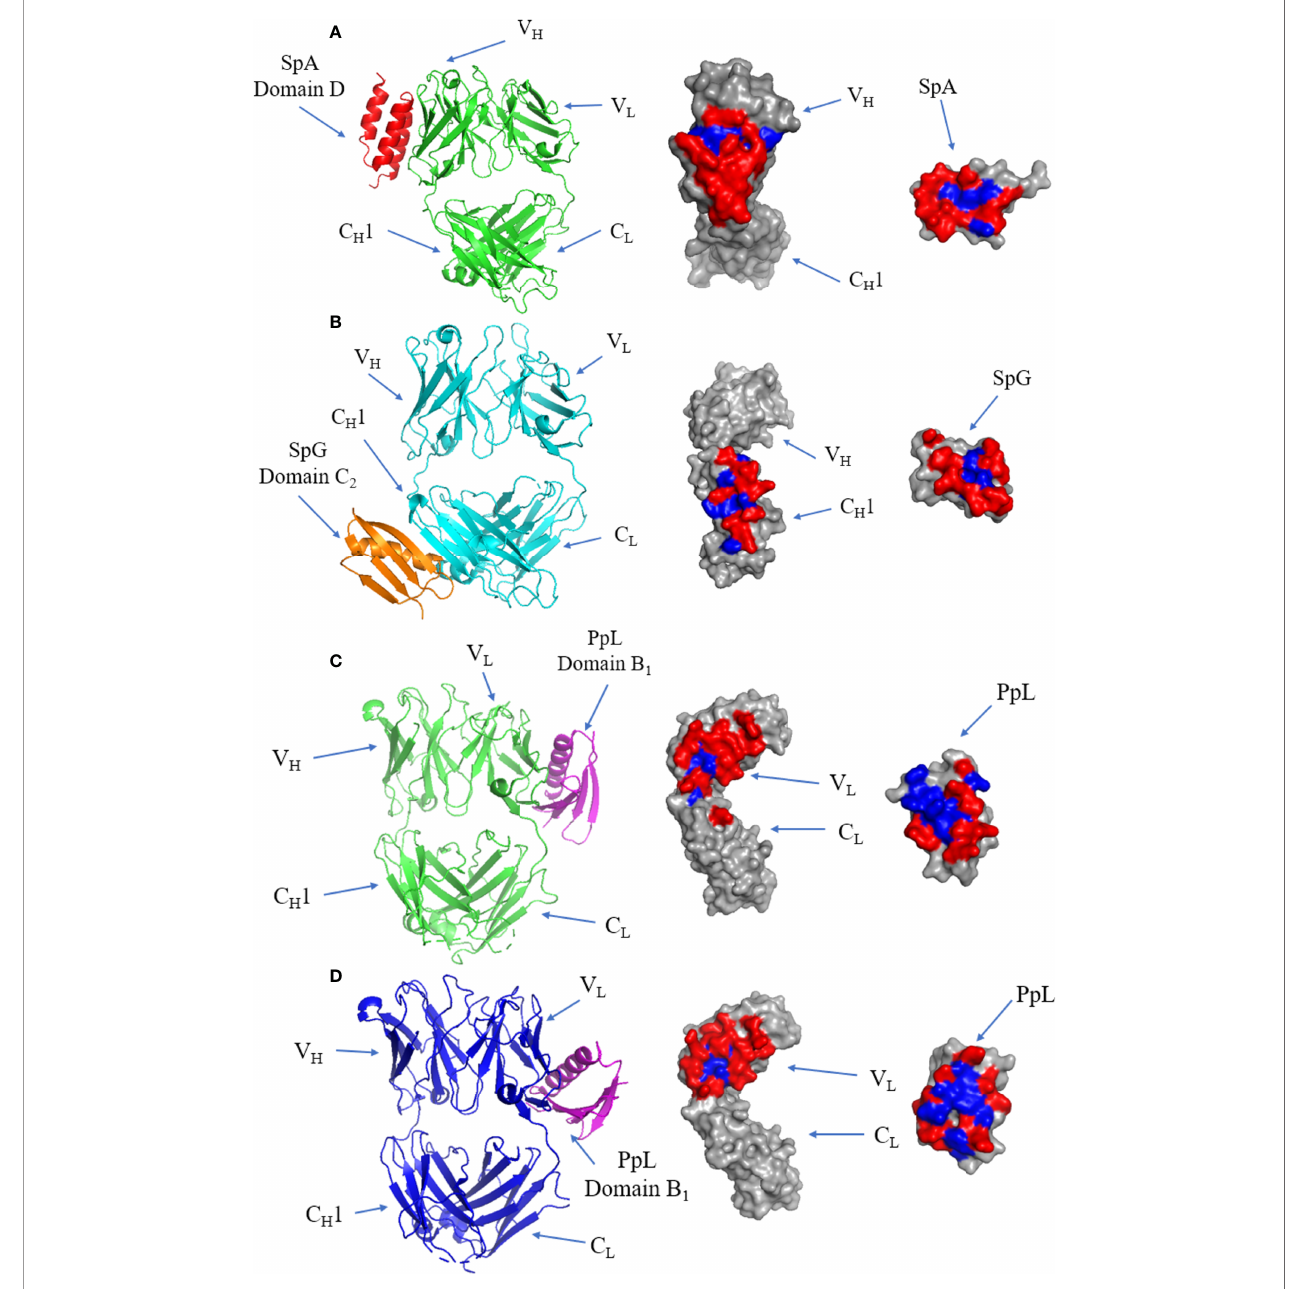
FIGURE 7 | Binding of SpA, SpG and PpL to antibody Fab fragments: (A) Left panel: ribbon plot of SpA (Red) bound to V H 3 domain of IgM Fab (Green) (PDB code: 1DEE). Middle panel: IgM Fab showing polar (red) and hydrophobic residues (blue). Right panel: SpA. (B) Left panel: ribbon plot of SpG (Orange) bound to C H 1 domain of IgG Fab (Cyan) (PDB code: 1QKZ). Middle panel: IgG Fab. Right panel: SpG. (C) Left panel: ribbon plot of PpL Domain B 1 (Purple) interface 1 bound to IgM Fab (Green) at the V L domain (PDB code: 1HEZ). Middle panel: IgM Fab. Left panel: PpL. (D) Left panel: ribbon plot of PpL Domain B 1 (Purple) interface 2 bound to IgM Fab (Blue) at the V L domain (PDB code: 1HEZ). Middle panel: IgM Fab. Right panel: